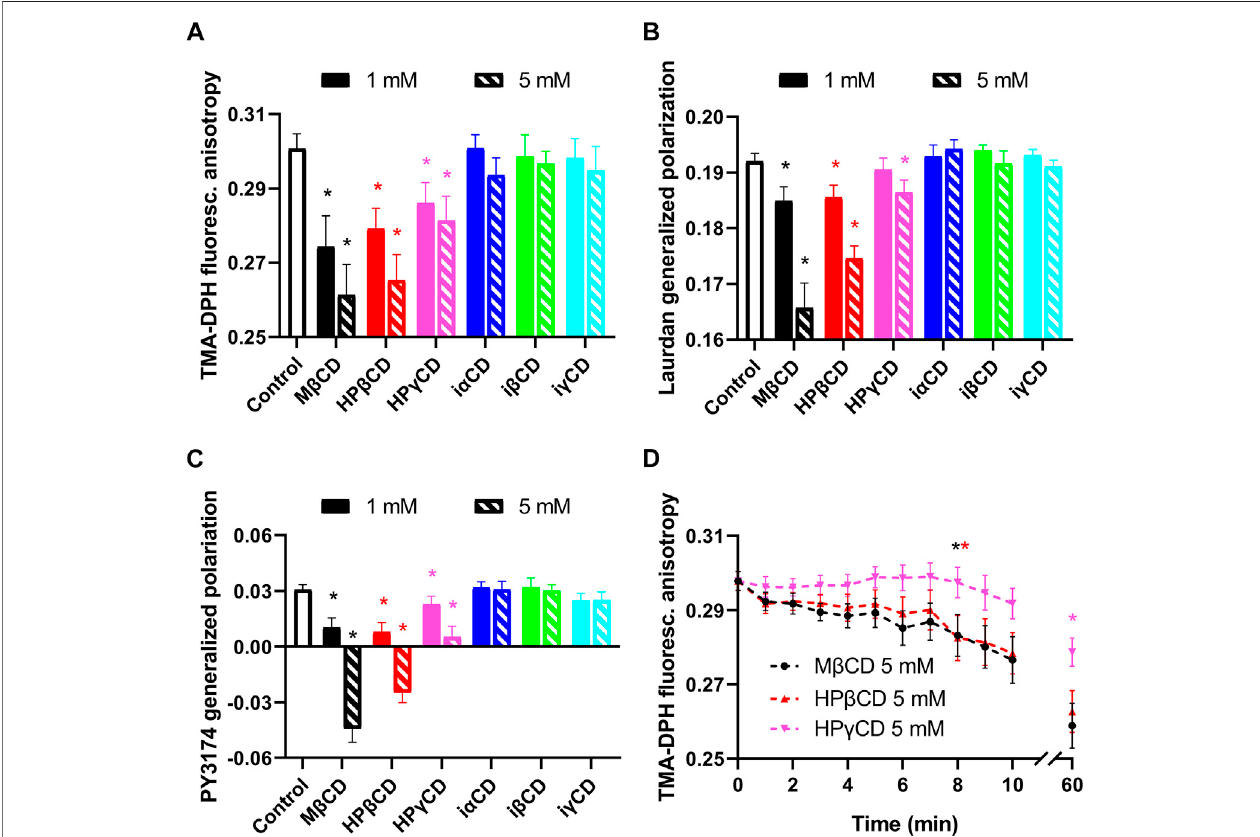
FIGURE 3 | Effects of CDs on membrane biophysical parameters. (A) CHO cells were treated with 1 or 5 mM CDs for 1 h, labeled with TMA-DPH and the fl uorescence anisotropy of the fl uorophore was determined using spectro fl uorometry. (B) Cells treated as above were alternatively labeled with Laurdan, followed by quanti fi cationofgeneralizedpolarization(GP)ofthedyewithspectro fl uorometry. (C) ControlandtreatedcellswerestainedwithPY3174andtheGPofthedyelocalizedinthe cellmembranewassubsequentlyexaminedusingconfocalmicroscopyandquantitativeimageanalysis.Cholesterol-extractingCDsaffectedbiophysicalparametersof thecellmembraneintheef fi cacyorderM β CD > HP β CD > HP γ CD,asindicatedbydecreasesinTMA-DPHanisotropyimplyingincreasedmembrane fl uidity(A),reductionsin Laurdan GP and PY3174 GP referring to increased membrane hydration or lower membrane lipid order (B, C). (D) Kinetics of membrane fl uidizing effects of CDs was examined after pre-staining CHO cells with TMA-DPH, which was followed by treating them with 5 mM ofCDs in the cuvette of the spectro fl uorometer. Treatments started immediatelybeforeinitiationofmeasurementsthatincludedrepeatedquanti fi cationof fl uorescenceanisotropyofthedyeeveryminuteinthe fi rst10 minofincubationand,as an end-point ofthe experiments, after 60 min. Time-dependent reductions inTMA-DPH anisotropywere observedinresponsetoall three examinedconventional CDs with theef fi cacyorderM β CD > HP β CD > HP γ CD.The fi rstsigni fi cantchangesappearedin8 mininresponsetoM β CDandHP β CD,whileinthecaseofHP γ CDreductionswere signi fi cantonlyafter60 min.Inthe fi gure,TMA-DPHanisotropyandLaurdanGPvaluesarerepresentedasmean ± SEMobtainedfrom n (cid:1) 9independentsamplescontaining approximately 100,000 cells. In panel C, mean PY3174 GP values ± SEM of 20 individual images obtained in fi ve independent experiments are plotted for the different treatments. Each image contained data of 5 – 10 cells of normal morphology with a total number of 100 – 200 cells per treatment. Asterisks (*) indicate signi fi cant differences comparedtocontrolsamples( p < 0.05,ANOVAfollowedbyTukey ’ sHSDtest).Forclarity,inpanelDthe fi rsttimepointismarkedbyanasteriskwheresigni fi cantdifferenceis observed in response to the given